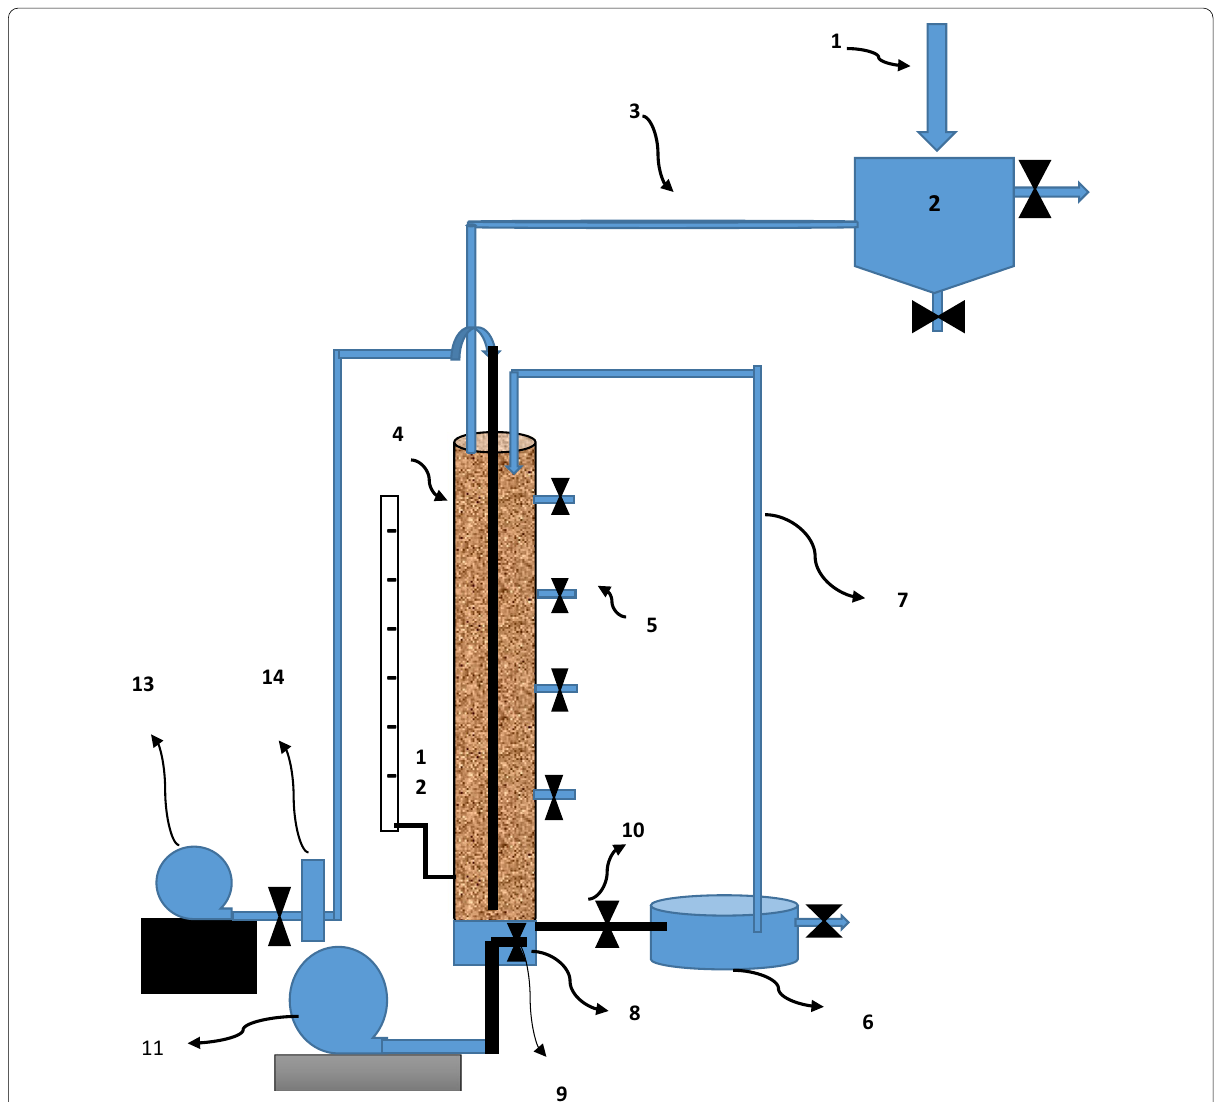
Fig. 1 Schematic of the BAF reactor (1. Wastewater Inlet 2. Primary settling tank 3. Wastewater inlet line 4. Reactor chamber 5. Sample valves 6. Secondary settling tank 7. Return sludge line 8. Sand filter 9. One-way valve 10. Effluent Valve 11. Backwash pump 12. Piezometer 13. Aeration pump 14. Aeration